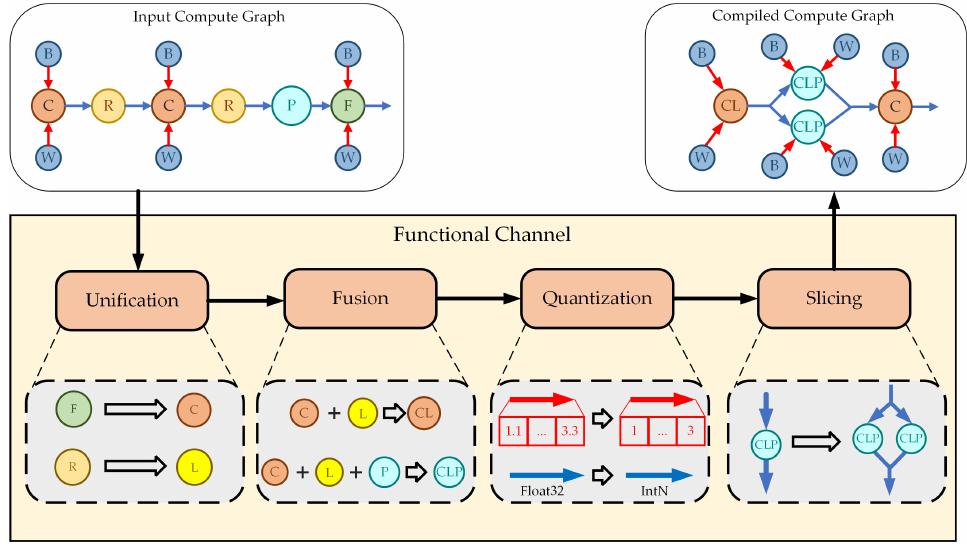
Figure 14. The flow chart of functional